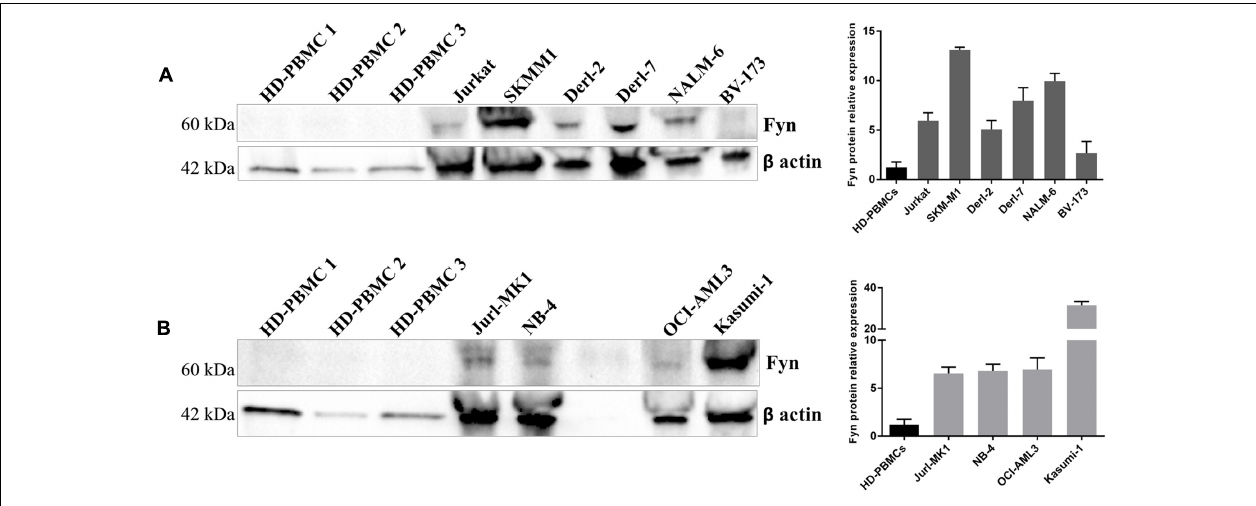
FIGURE 4 | Fyn expression in different hematological malignant cells. Western Blotting (WB) analysis of Fyn levels in 3 HD-PBMCs compared to lymphoid cell lines (A) and in three HD-PBMCs compared to myeloid cell lines (B) . Quantification of Fyn protein levels was normalized with β -actin bands. The bar-graphs represent mean with SD from three independent